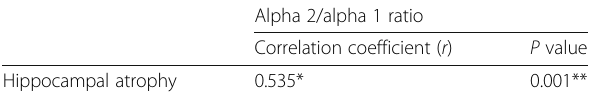
Table 5 Correlation between alpha 2/alpha 1 ratio and hippocampal atrophy among DM with MCI group